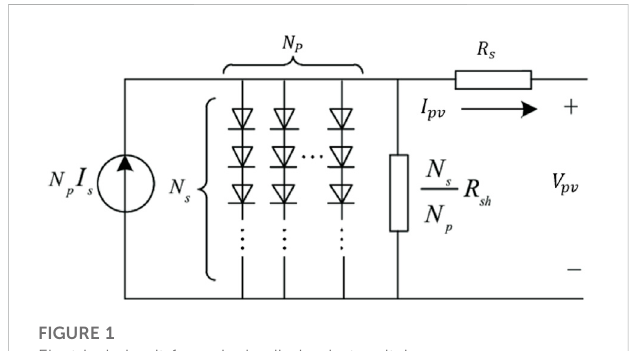
FIGURE 1 Electrical circuit for a single-diode photovoltaic array.